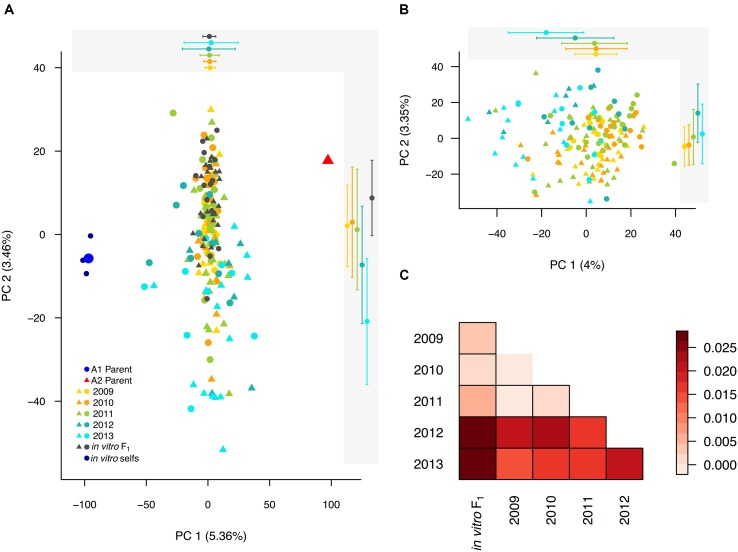
Population structure in the biparental field population relative to the in vitro F1 and founding parents. (A) Field isolates, in vitro F1, in vitro selfs, and consensus parental genotypes plotted along the first two principal components (PCs). Each year is represented by a different color, with the A1 and A2 parental isolates indicated by blue and red, respectively. Shapes indicate the mating type of each isolate, with circles (A1) and triangles (A2). For each year (2009–2013) and the in vitro F1 the means (± one standard deviation) for the first (top) and second (right) PCs are plotted in the shaded gray boxes. (B) A PCA of only the field isolates, with color and symbol scheme consistent with (A). As in (A), the means (± one standard deviation) for the first two PCs are plotted for each year. (C) Pairwise FST for comparisons between sample years and the in vitro F1 represented by a heat map, with more positive FST values increasingly red. A border indicates that the pairwise FST value was significantly different from 0, as tested by 1000 random SNP permutations.